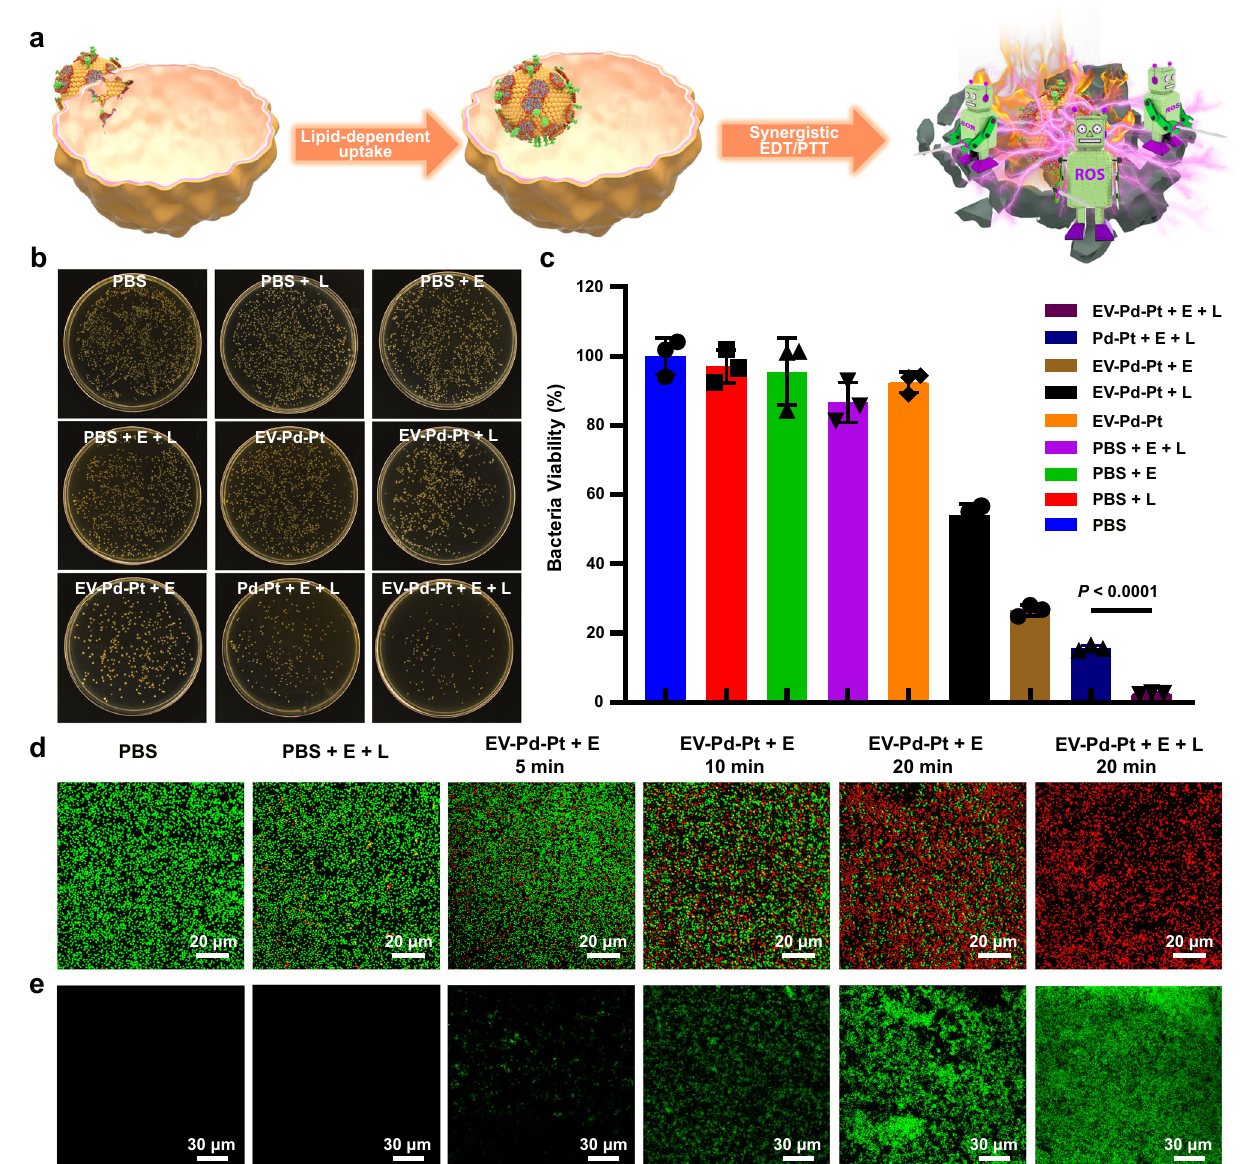
Fig. 5 | In vitro antibacterial activity of EV-Pd-Pt nanoparticles. a Schematic illustrationoftheuptakeandantibacterialeffectofEV-Pd-Pt.KillingeffectofEV-Pd- Pt against S. aureus by the plate counting method. Photographs of S. aureus colo- nies ( b ) and corresponding viability ( c ) after different treatments. Data are pre- sentedasmeanvalues±SD( n =3independentsamples).Statisticalsigni fi cancewas